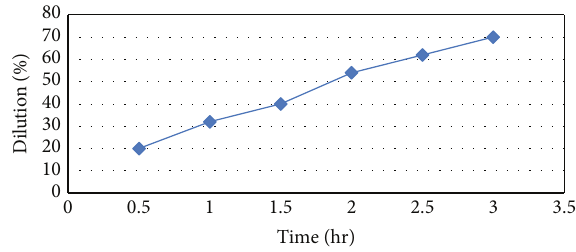
Figure 10: Dilution% as a function time (concentrated Ezz Steel treated wastewater from FO after 6 hr + RO concentrate) (2nd stage FO-batch process).